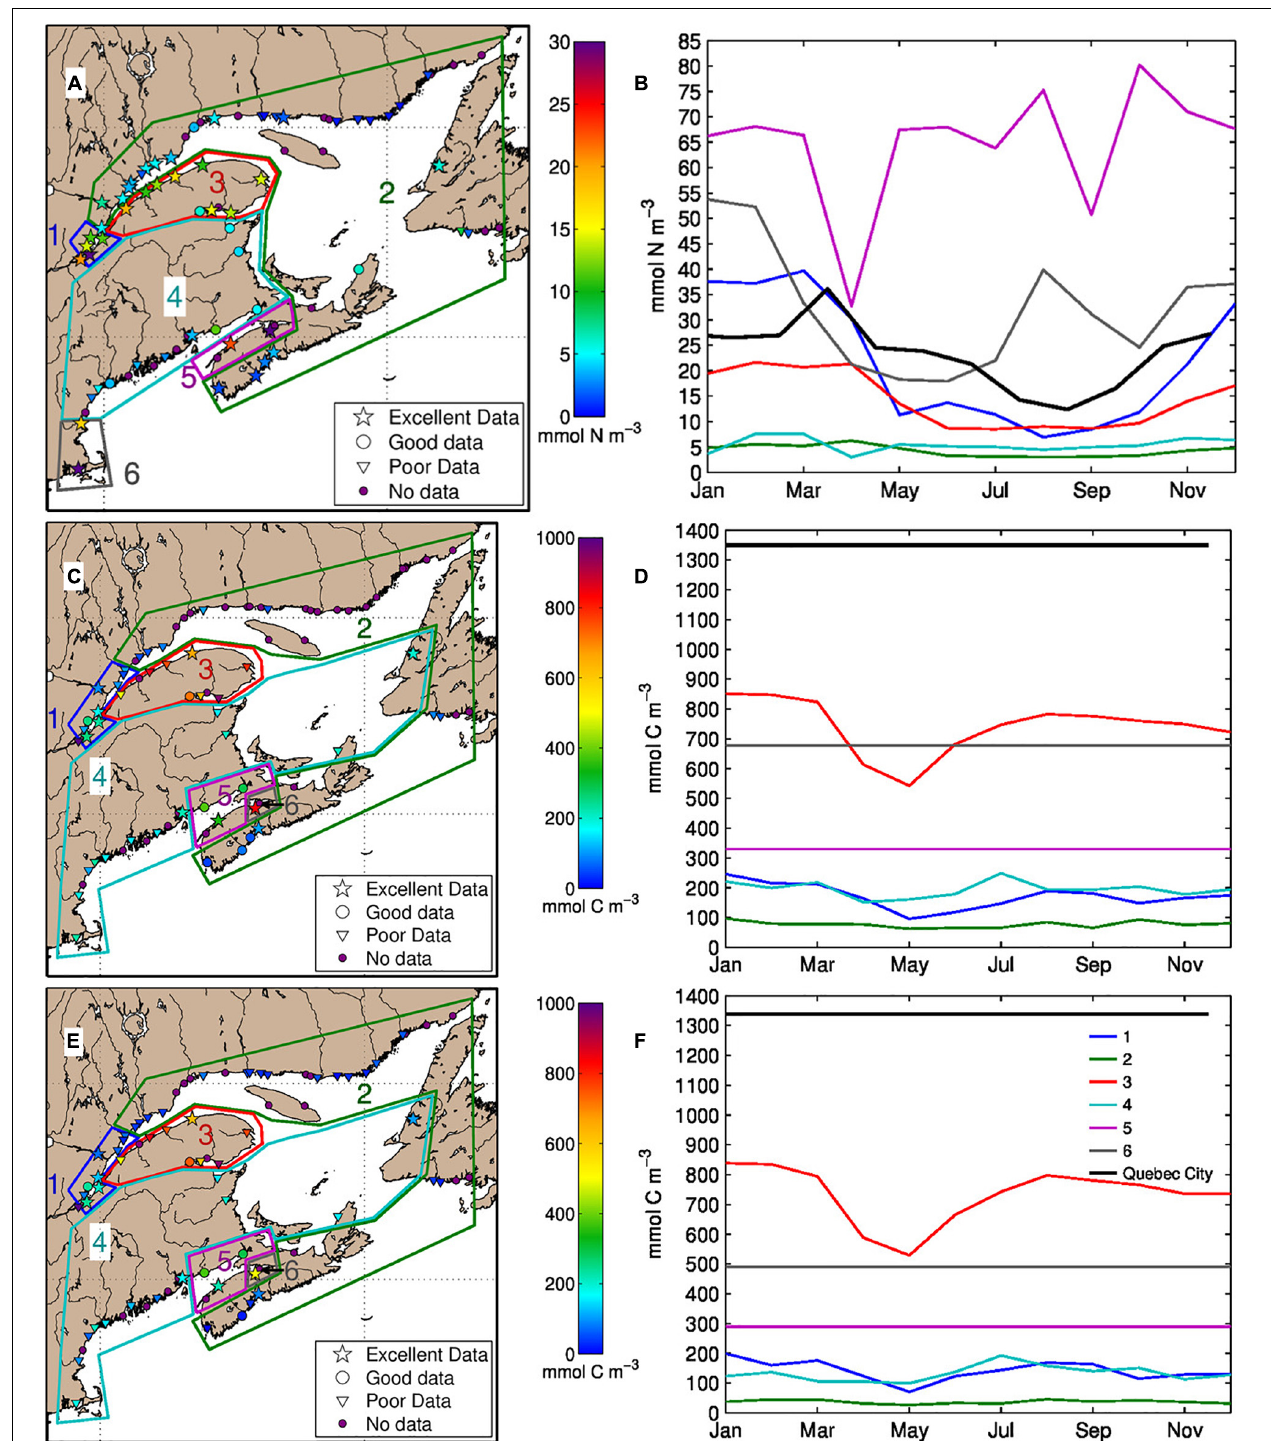
FIGURE 3 | Contours of the six regions with rivers having similar characteristics for nitrate (A) , dissolved inorganic carbon (C) , and total alkalinity (E) . The annual mean concentration are given for each rivers (colorbar) when data are available. The shape of the symbols indicates the quality of sampling in terms of frequency or when no data are available (purple circle). The panels to the right show the corresponding monthly climatology for each region and for Quebec City, or the constant annual mean when a climatology could not be calculated (B,D,F) . The regions are different for nitrate than for dissolved inorganic carbon and total alkalinity.